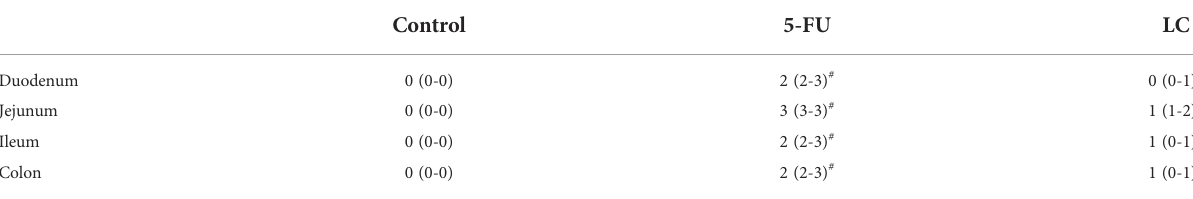
Datarepresentmedianvalues(andrange)ofscoresfrom0to3:Score0,normalhistological fi ndings;Score1,villusblunting,lossofcryptarchitecture,sparsein fl ammatorycellin fi ltration, vacuolizationandedemanormalmusclelayer;Score2,villusbluntingwithfattenedandvacuolatedcells,cryptnecrosis,intensein fl ammatorycellin fi ltration,vacuolizationandedemaand normal muscle layer; Score 3, villus blunting with fattened and vacuolated cells, crypt necrosis, intense in fl ammatory cell in fi ltration, vacuolization and edema and muscle layer showing edema,vacuolizationandneutrophilicin fi ltration.Villusalterationswerenotconsideredforcolonscores.DatawereanalyzedwithKruskal-WallisandDunn ’ stests(n=5). # P<0.01versus control group, *P<0.01 versus 5-FU group. Lactobacillus casei (LC).